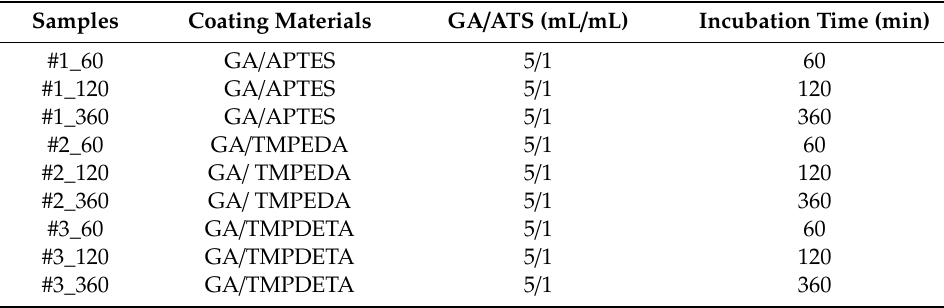
Table 3. Incubation conditions of PTFE substrates and their abbreviations.